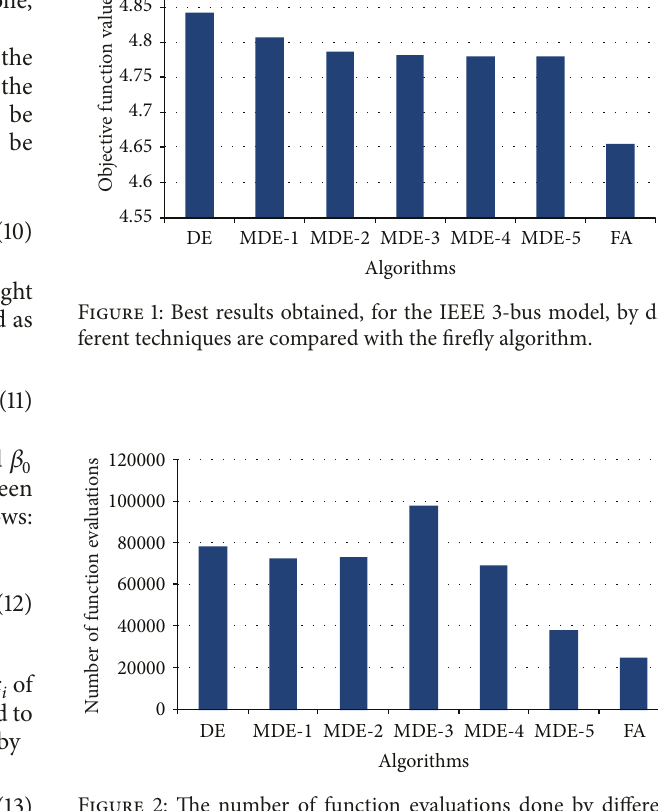
Figure 2: The number of function evaluations done by different algorithms to solve the 3-bus